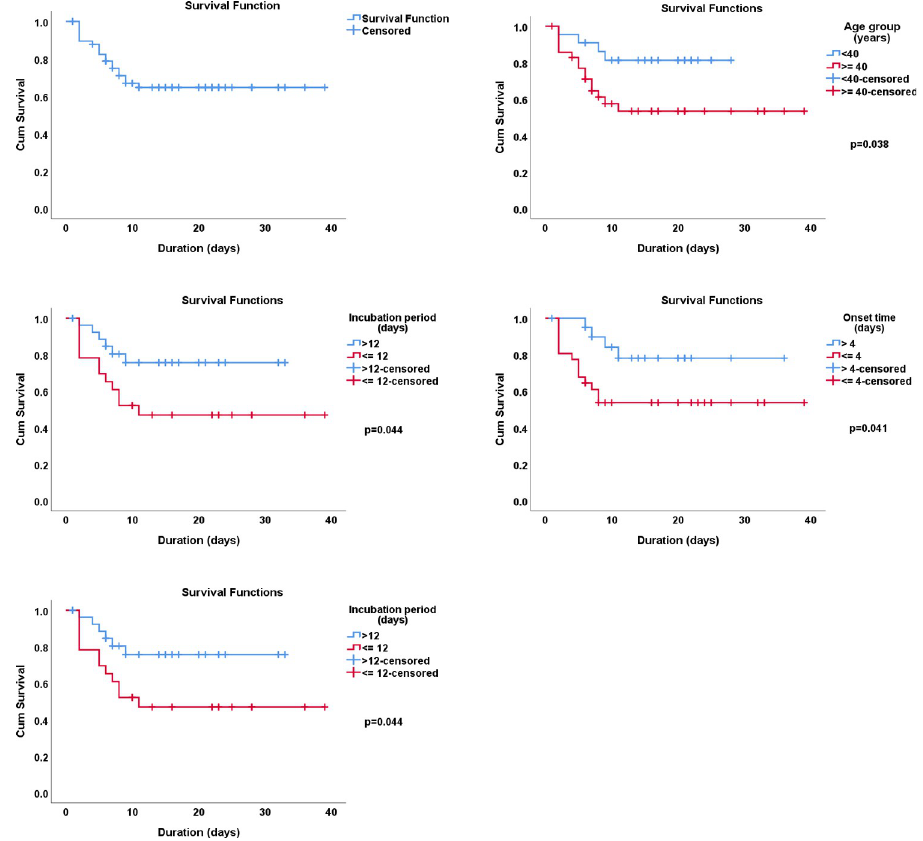
Fig 3. Kaplan-Meier survival curves showing the probability of overall survival and survival across different groups of tetanus patients